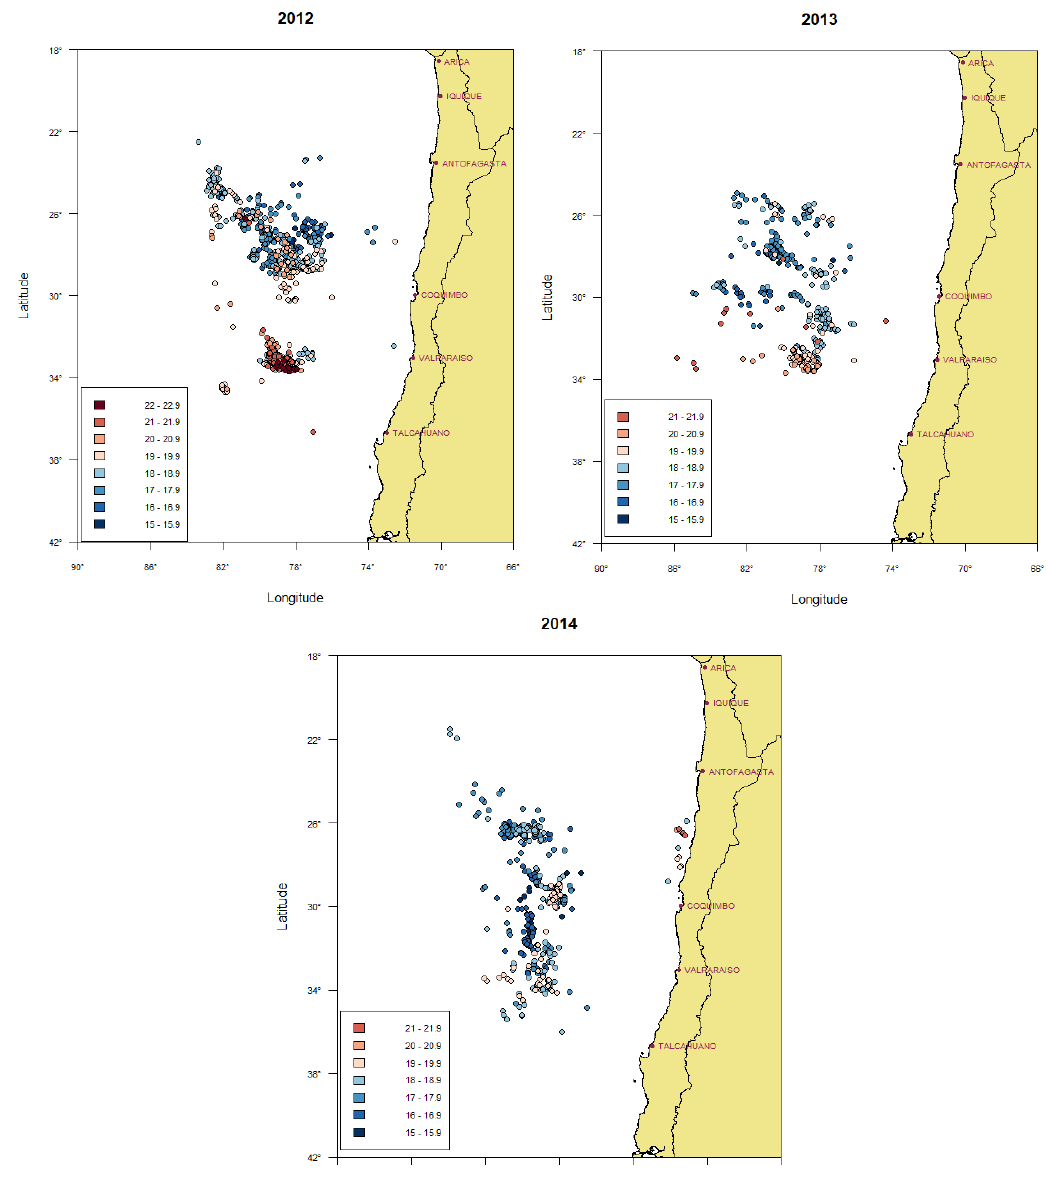
Figure 4. Spatial distribution of Sea Surface Temperature (SST) observations by year (21 ◦ 31 (cid:48) –36 ◦ 39 (cid:48) LS, 71 ◦ 08 (cid:48) –85 ◦ 52 (cid:48)